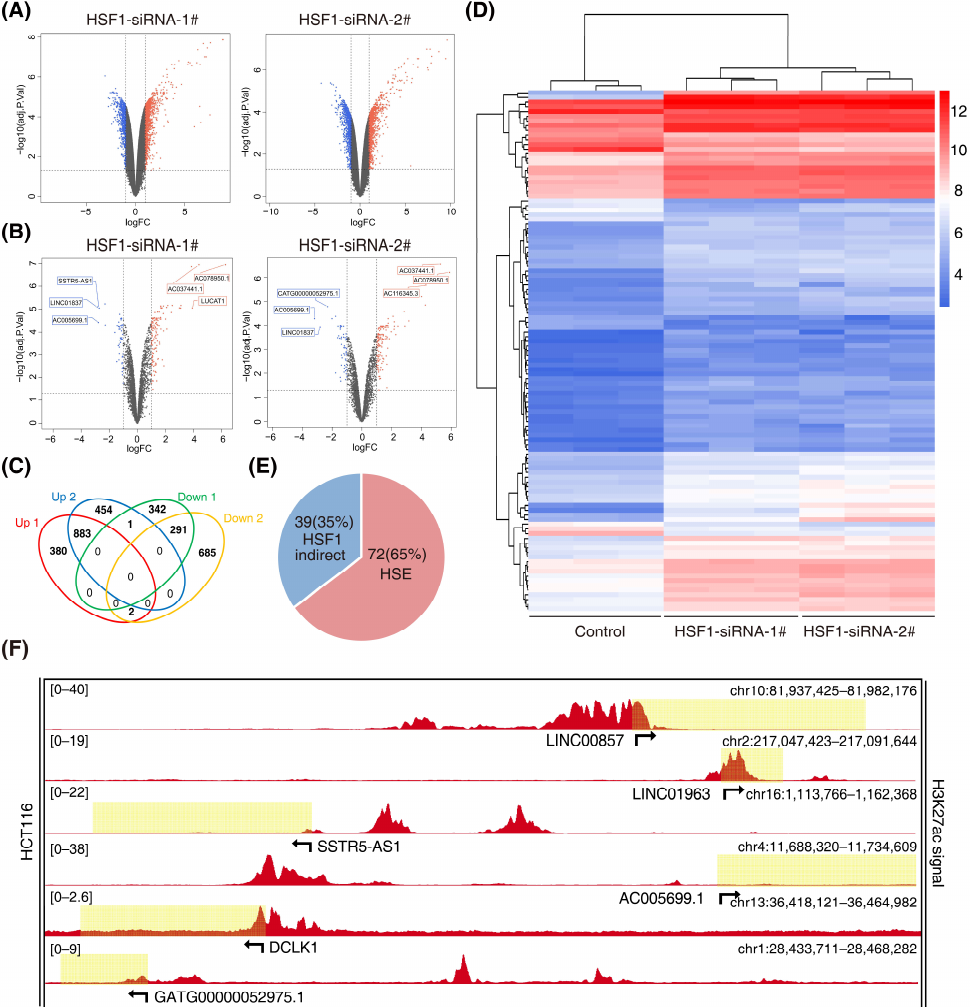
Figure 2. Screening for HSF1-associated lncRNAs. ( A ) Volcano plots of differentially expressed lncRNAs after HSF1 knockdown ( p value < 0.05 and |log2FC| ≥ 1.0). ( B ) Volcano plots of differentially expressed enhancer-mediated lncRNAs after HSF1 knockdown ( p value < 0.05 and |log2FC| ≥ 1.0). ( C ) Venn diagrams of overlapping differentially expressed lncRNAs from an intersection of upregulated and downregulated lncRNAs ( p value < 0.05 and |log2FC| ≥ 1.0). ( D ) The heatmap shows the clustering of enhancer-mediated lncRNAs after HSF1 knockdown. ( E ) The number of HSF1-dependent enhancer-mediated lncRNAs with or without an HSF1 binding site (HSE) in their promoter regions. ( F ) Gene tracks of H3K27ac ChIP–seq occupancy at representative HSF1-dependent enhancer-mediated lncRNA gene loci in HCT116 cells. Data derived from the ENCODE database. Data represent the mean ± SD, n ≥ 3.